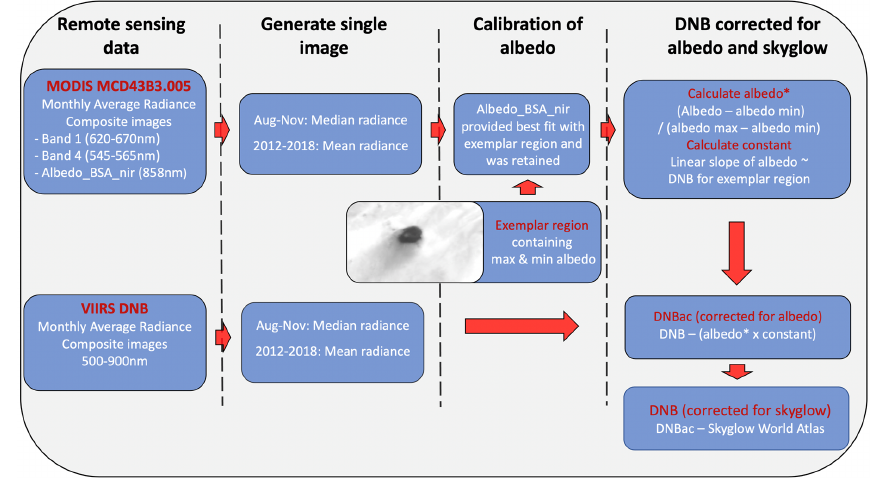
Figure 1. Flow diagram illustrating how the day/night band (DNB) layer corrected for albedo and skyglow was generated. skyglow was